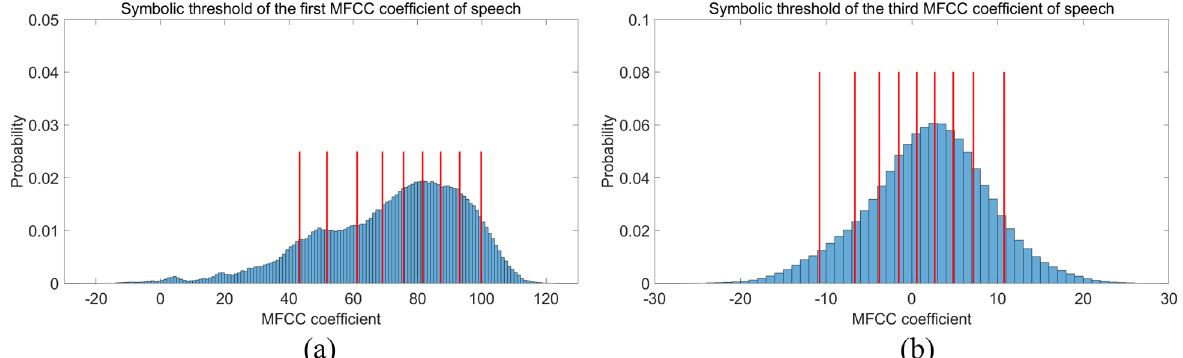
Fig. 4 a The probability distribution of the first coefficient. b The probability distribution of the third coefficient. The red line represents the threshold for symbolization, divided into ten intervals and represented by 1–10,